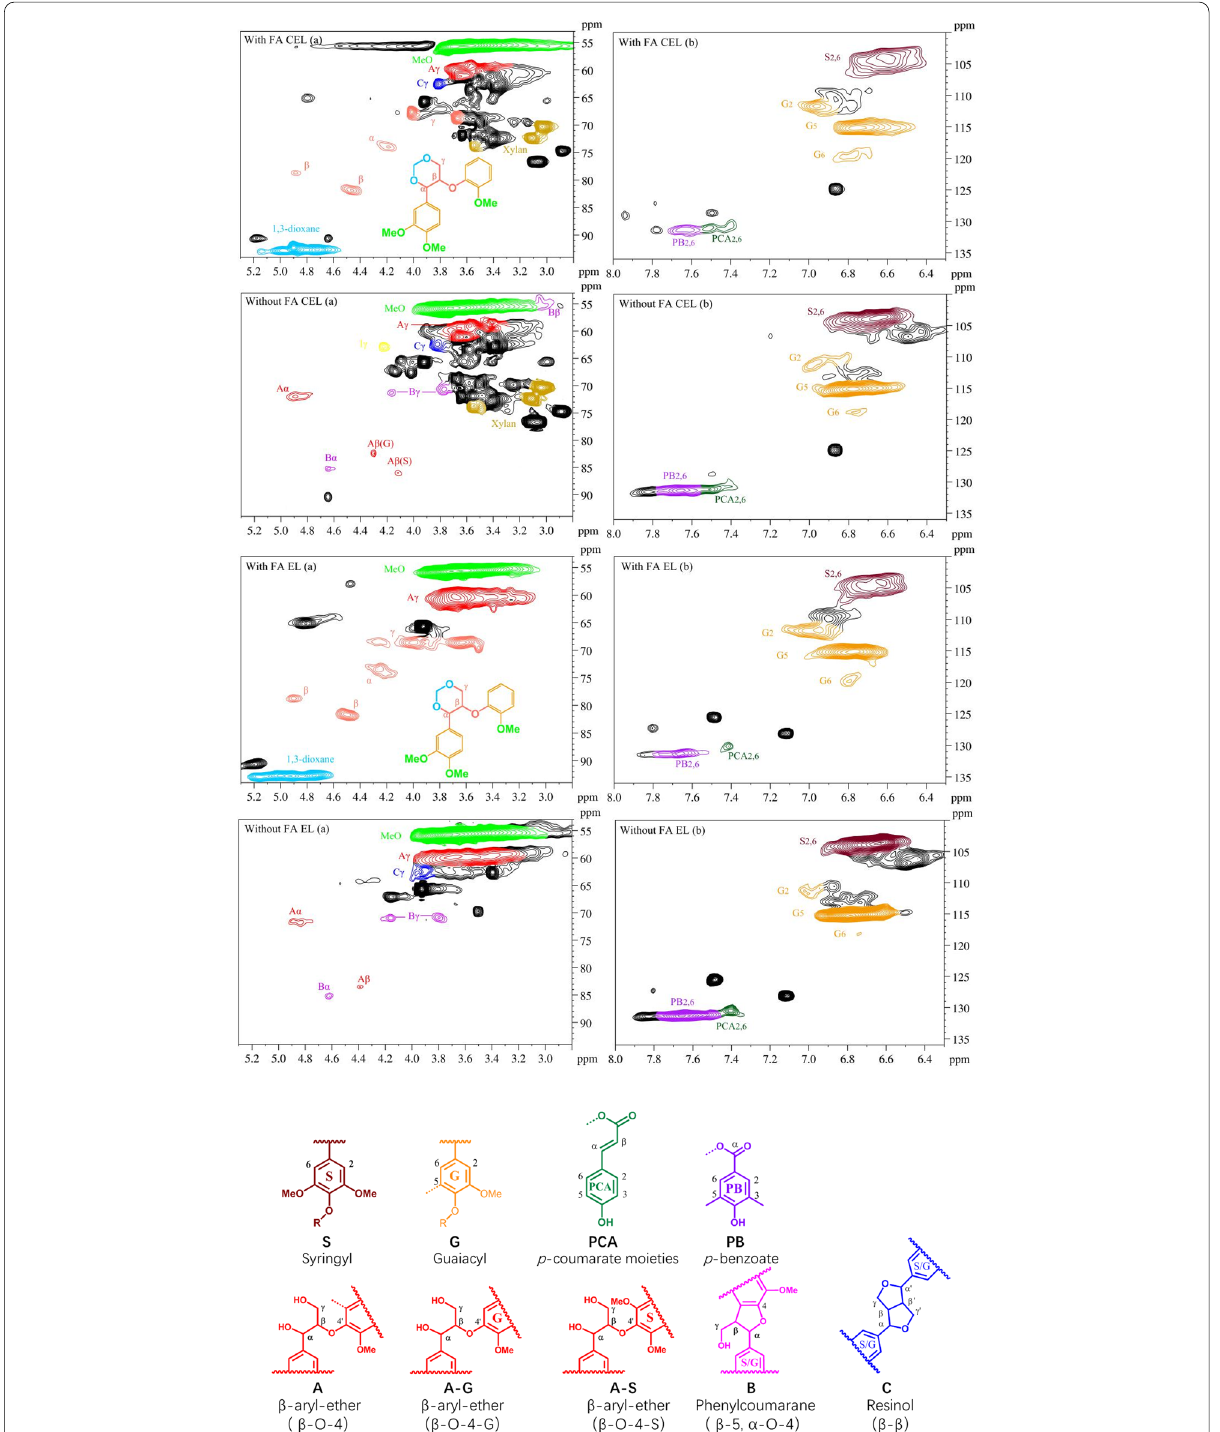
Fig. 7 Side-chain (left) and aromatic regions (right) in the 2D HSQC NMR spectra of CEL and EL obtained from different pretreatment conditions and their main